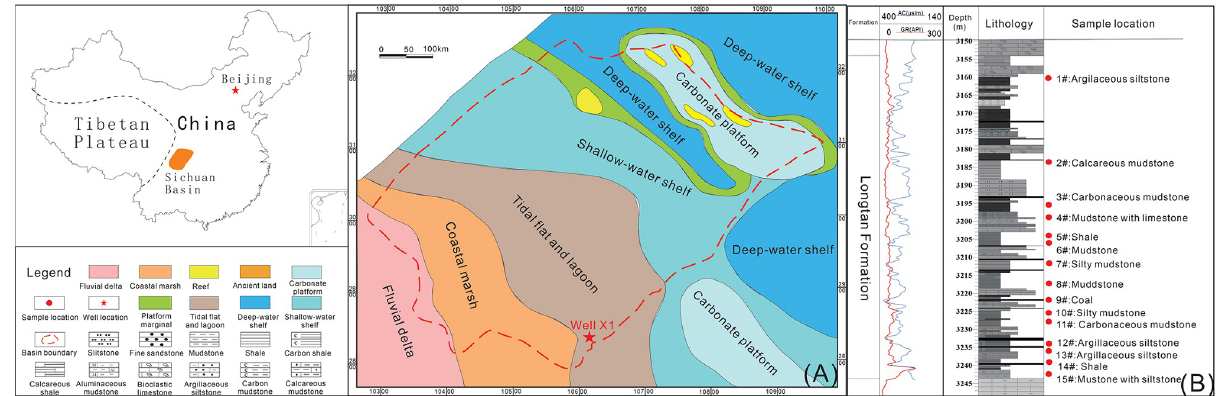
Fig 1. Geographical location, sampling location, and stratigraphic description of the Longtan Formation in the study area: (A) Sample location; (B) Well X1 in Longtan Formation (modified from [30]).